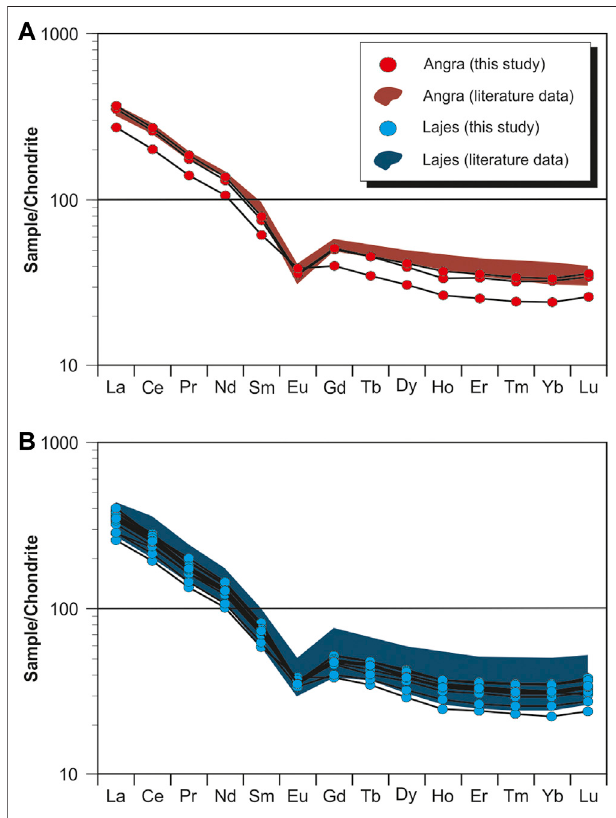
FIGURE 14 | Chondrite-normalised REE patterns for the Angra (A) and the Lajes (B) ignimbrites. Coloured fi elds denote the total range of literature data derived from Tomlinson et al. (2015), D ’ Oriano et al. (2017), and Jeffery et al. (2017). Chondrite values taken from Sun and McDonough (1989).